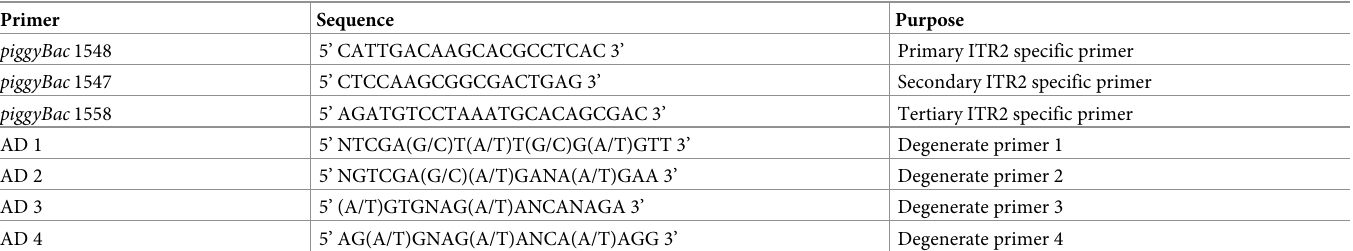
Table 2. Primers used in the TAIL